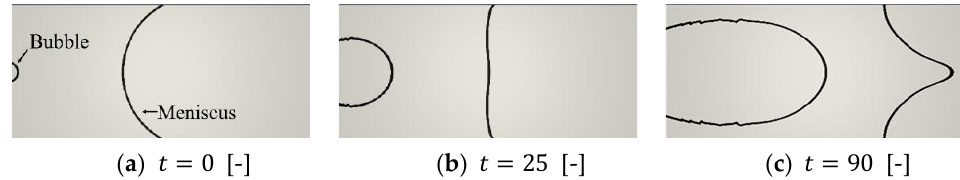
Figure 4. Time evolution of microjet by the single bubble. Interfaces are shown by the density gradient.